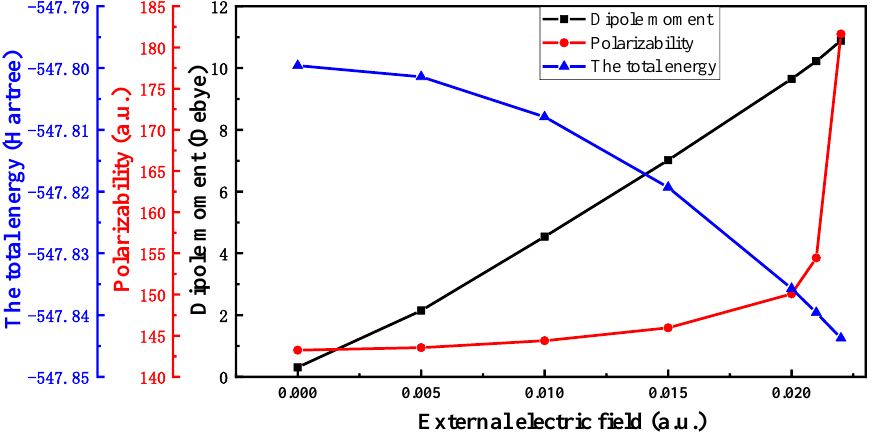
Figure 3. The variation of the total energy, dipole moment, and polarizability. 3.2. Effect of the External Electric Field on the Geometry of the Molecule After optimizing the ENB-EPDM molecule to obtain a stable spatial structure, the variation trend of distance R [1,30] between the leftmost C1 atom and the rightmost C30 atom of the molecular chain under different external electric fields (0~0.0255 a.u.) is shown in Figure 4, which gradually becomes larger with the increase in the electric field intensity. Due to the effect of an electric field, the positive and negative charges transfer in the mo- lecular system, which produces a certain stretch effect on the molecular chain and reduces the stability of the molecular geometric structure. The dynamic changes of the ENB-EPDM molecular chain under different electric field intensities are shown in Figure 5, where the direction of the applied electric field is the trend of the molecular chain extension. When the electric field intensity reaches 0.0255 a.u., the C-H bond of the ENB-EPDM molecule is broken, as shown in Figure 5c.